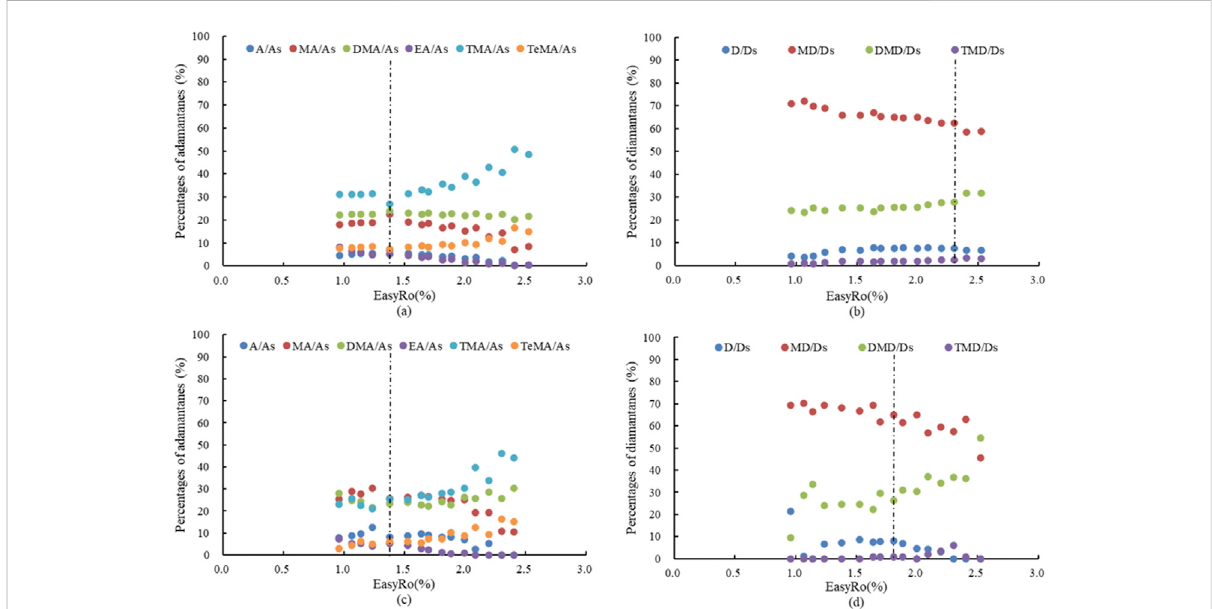
FIGURE 3 Thepercentagevariationofthedifferentalkyl-substitutedadamantanes (A,C) anddiamantanes (B,D) ofthetotaladamantanesanddiamantanes withextract (A,B) andextractedmudstonepyrolysis (C,D) ,respectively.(A,adamantane;MA,allmethyladamantanes;DMA,alldimethyladamantanes; EA,all ethyladamantanes; TMA,all trimethyladamantanes; TeMA, all tetramethyladamantanes; As, all adamantanes; D, diamantine; MD, all methyldiamantanes; DMD, all dimethyldiamantanes; TMD, all